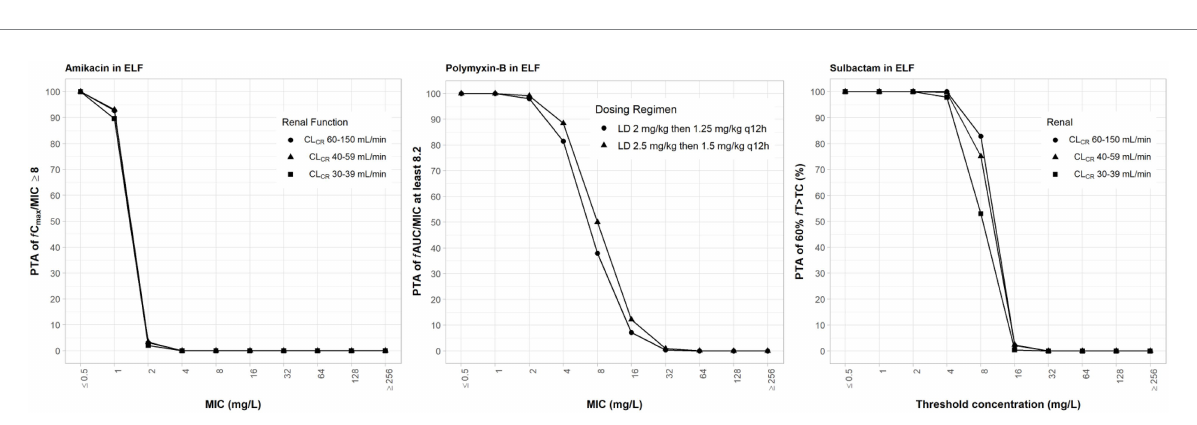
FIGURE 4 Probability of target attainment (PTA) of 60% f T >MIC and 8 f C max /MIC for sulbactam and amikacin dosing regimens by renal function category, respectively, and PTA of f AUC/MIC of at least 8.2 for polymyxin-B dosing regimens. PTA values were computed based on steady-state drug concentrations in the epithelial lining fluid and their respective epithelial lining fluid penetration. LD, loading dose; CL CR , creatinine